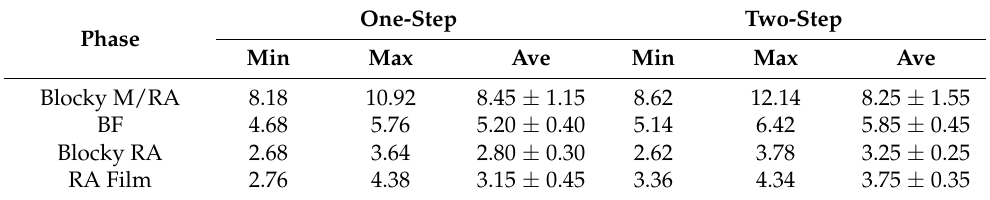
Table 2. Nanohardnesses of the different phases for the investigated steel (GPa).